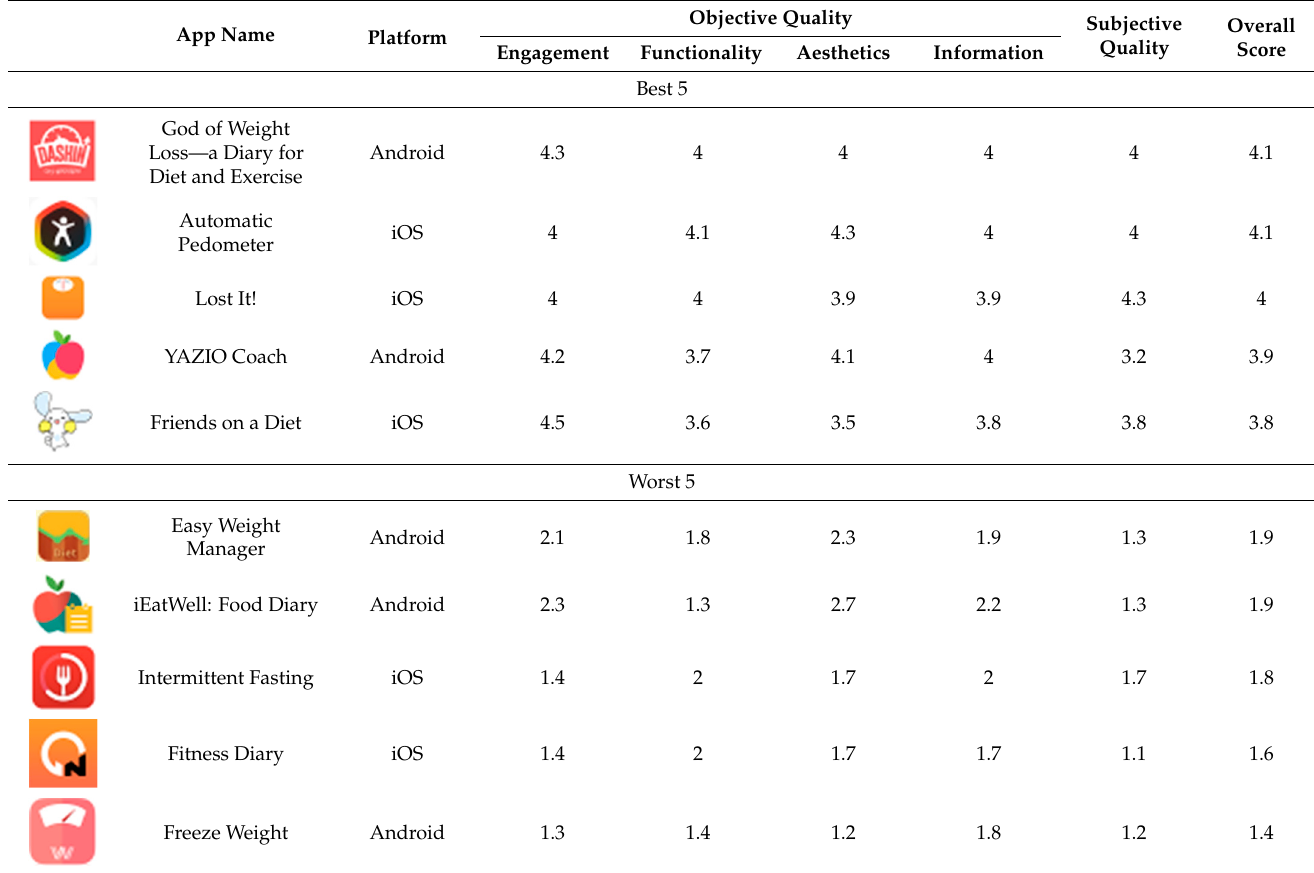
Table 2. MARS scores of individual apps: best and worst apps.